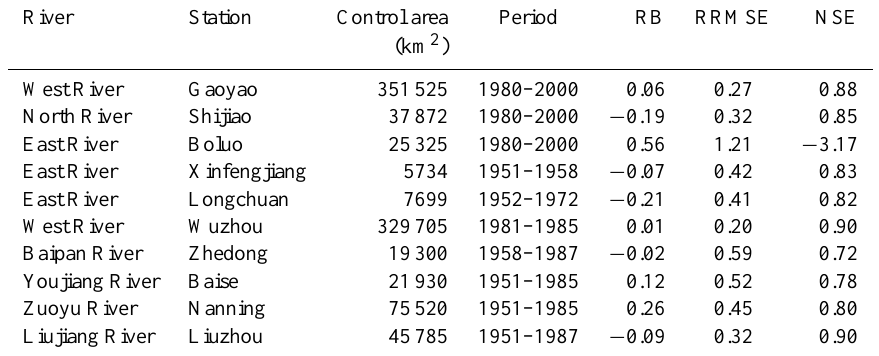
Table 1. Runoff simulation results at a monthly time step for 10 gauging stations over the Pearl River basin (in Fig.